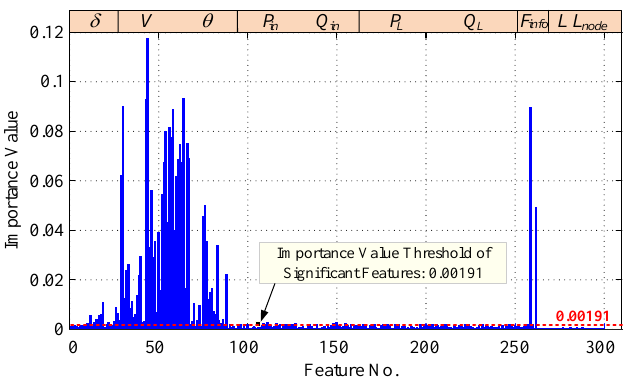
Figure 6. Features selection with Fisher discrimination.